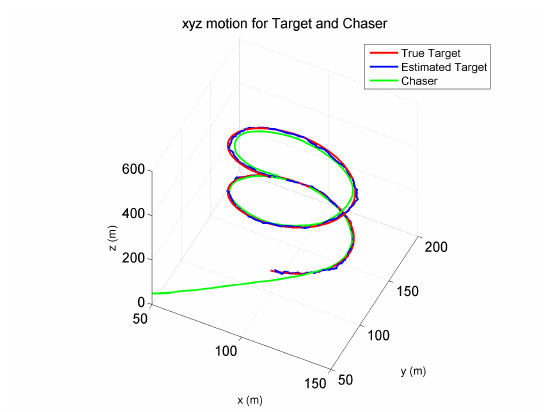
Figure 20. Position tracking error (Case 2C).